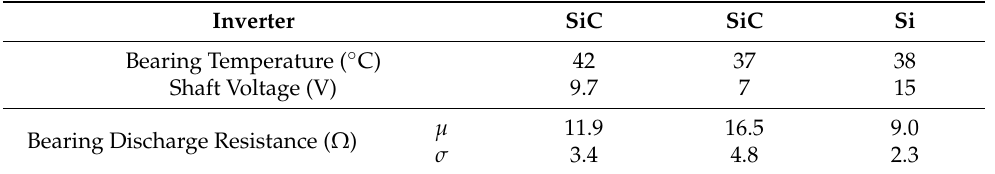
at 9.7 V, 42 ◦ C, and 7 V, 37 ◦ C, and for the Si inverter at 15 V, 38 ◦ C.